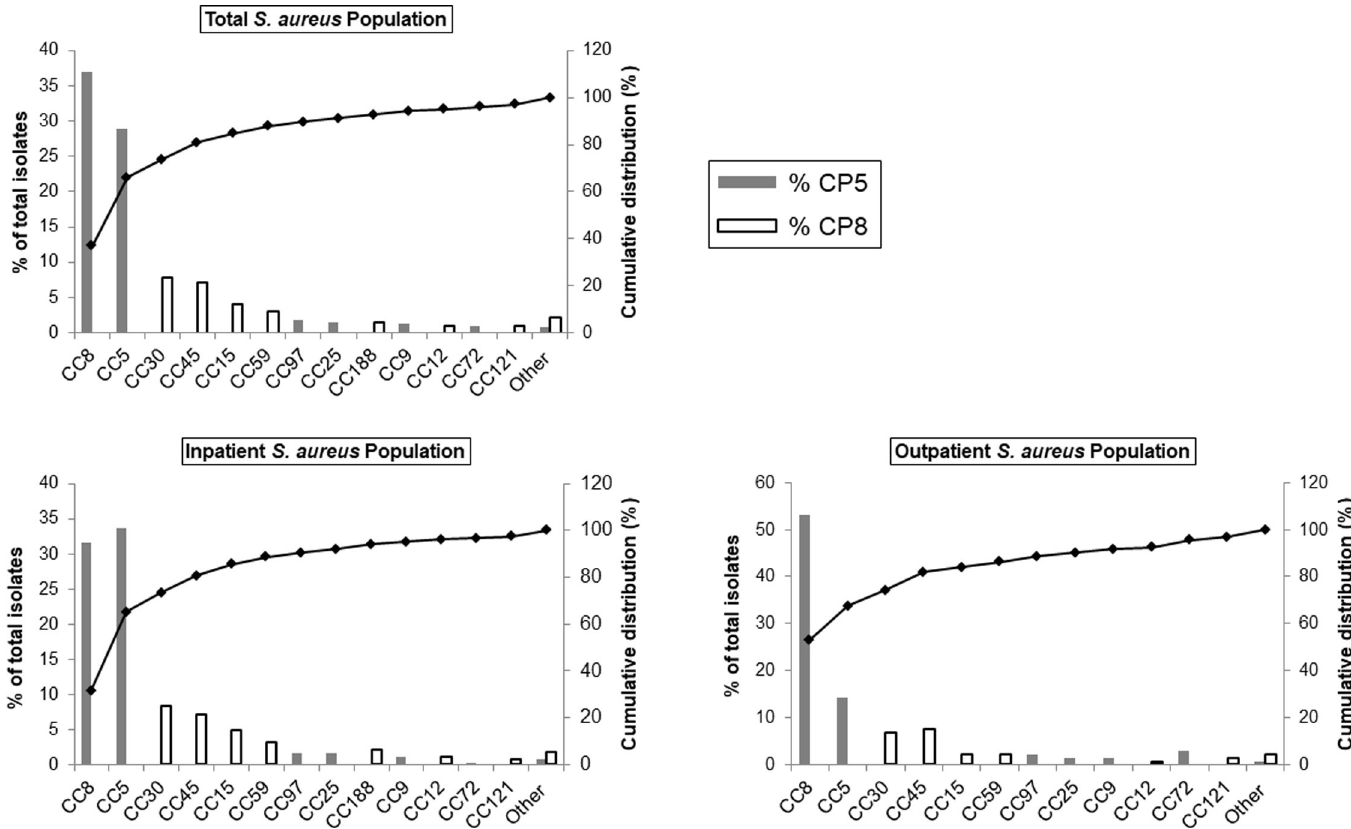
Fig 2. Distribution of clonal complexes (CC) and capsular polysaccharide (CP) genotypes by ward source.